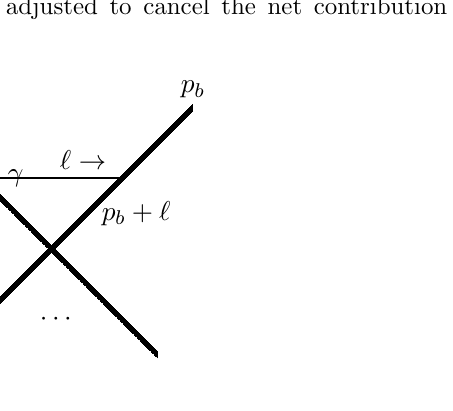
Figure 3 . One loop contribution to (cid:0) ( n ) . There are other diagrams related to this by permutations of the external scalar